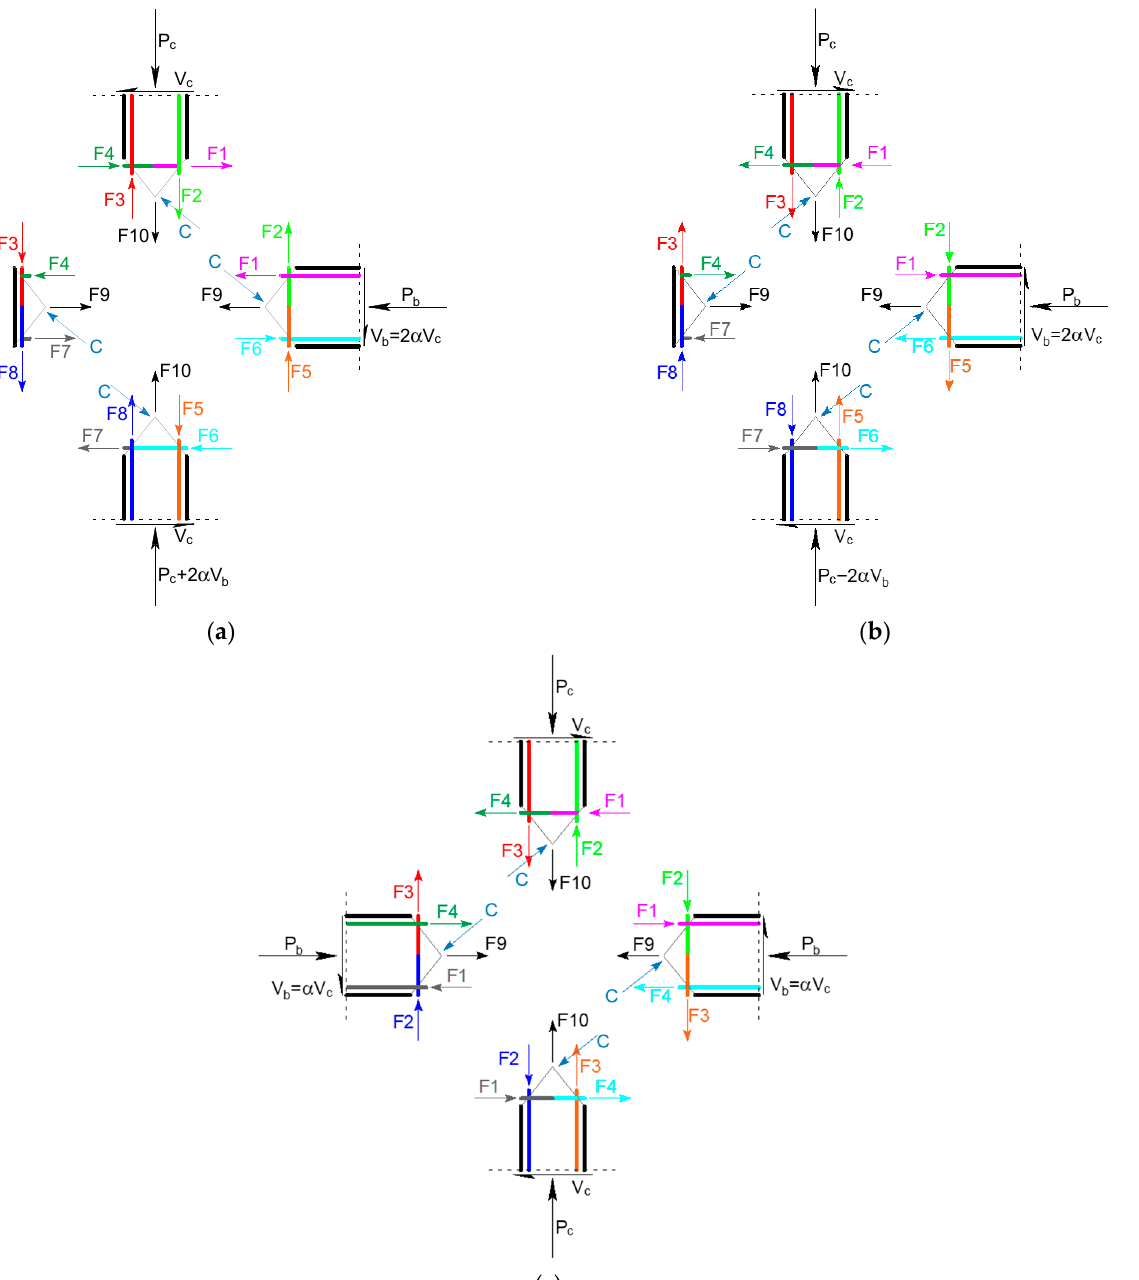
Figure 2. Internal equilibrium conditions for the RC joints: ( a ) positive direction of the column shear acting on the T-shaped RC joint, ( b ) negative direction of the column shear acting on the T-shaped RC joint, and ( c ) positive direction of the column shear acting on the X-shaped RC joint (negative is symmetrical).